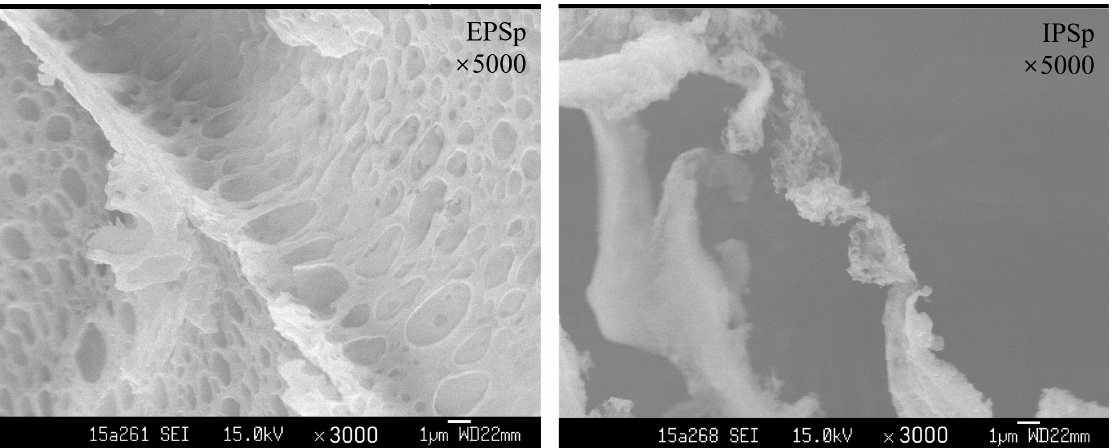
Figure 2. Scanning electron microscopy observation of EPSp and IPSp. EPSp: purified Cs-4 exopol- ysaccharides, IPSp: purified Cs-4 intracellular polysaccharides.